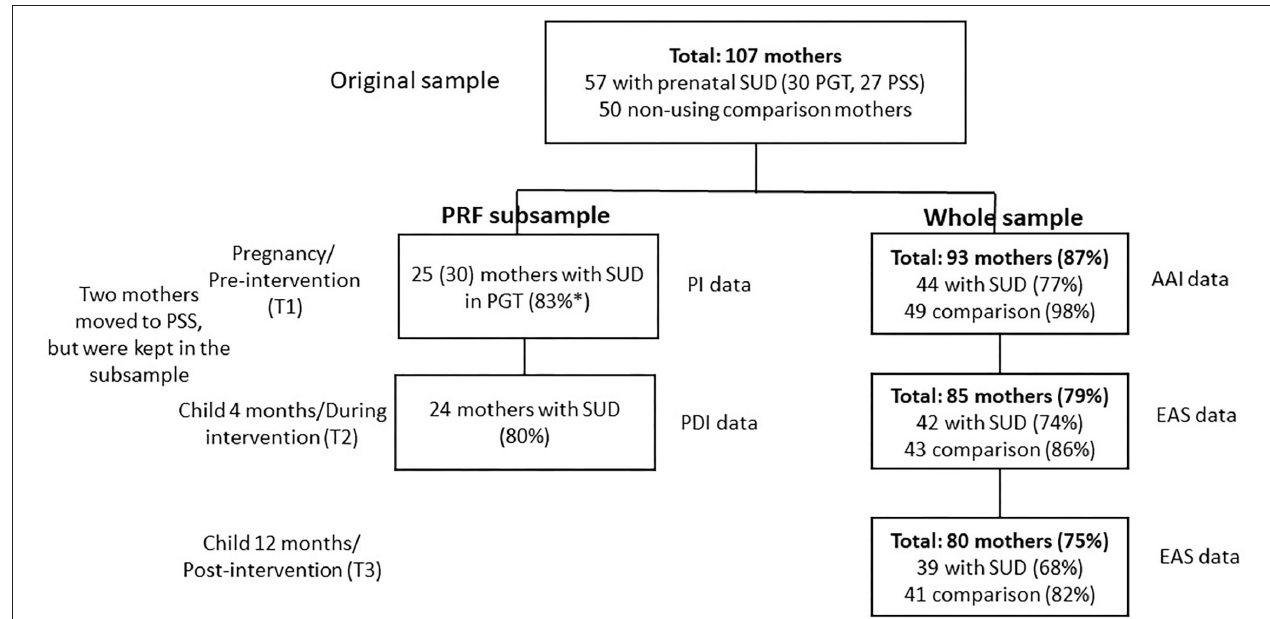
FIGURE 1 | The participation flow chart of the study. SUD, substance use disorder; PGT, psychodynamic group therapy; PSS, Psychosocial support; PI, Pregnancy interview; PDI, Parent development interview; AAI, Adult Attachment Interview; EAS, Emotional Availability Scales. All mothers were included in the analyses based on intention to treat, and missing data was replaced with Multiple Imputation (MI). *30 mothers participated in PGT and had other data, but 5 had given birth at T1, so PI was not conducted for them and their data was imputed. Similarly, some mothers lacked prenatal AAI data, but were included in the study as they had other data. The rate of missingness was slightly higher for T2–T3 relapses than for T2 and T3 EA, 35 mothers with SUD (61%) reported whether they had had